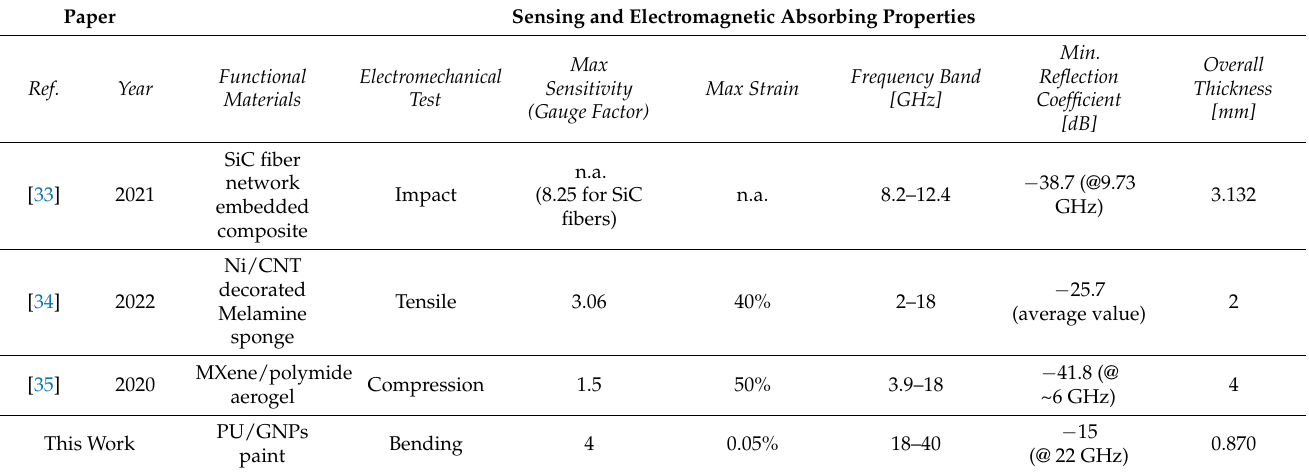
Table 1. Comparison of prior work and current